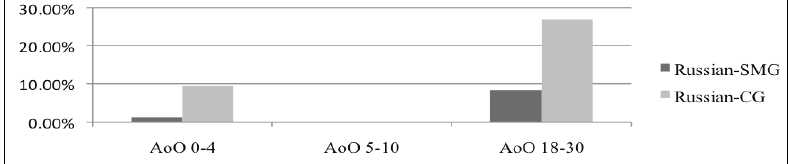
Figure 11: AoO of the participants and non-target test production